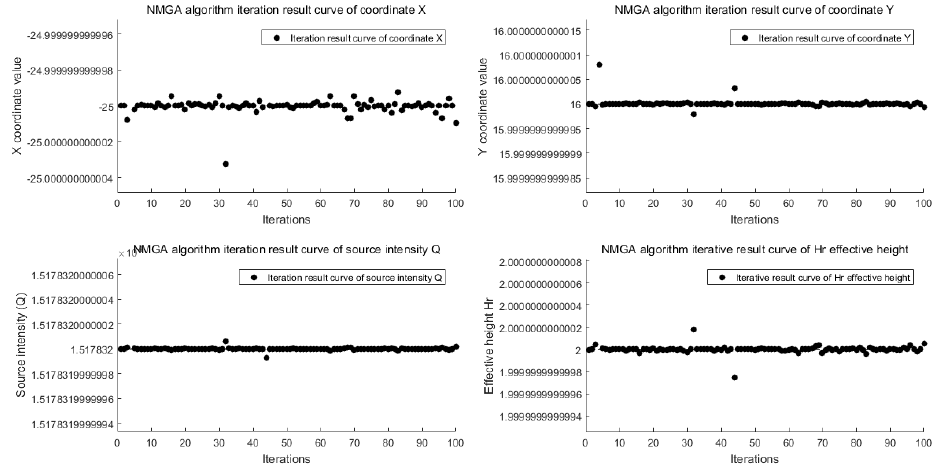
Figure 4. Absolute error graph of the NMGA algorithm for 100 rounds.